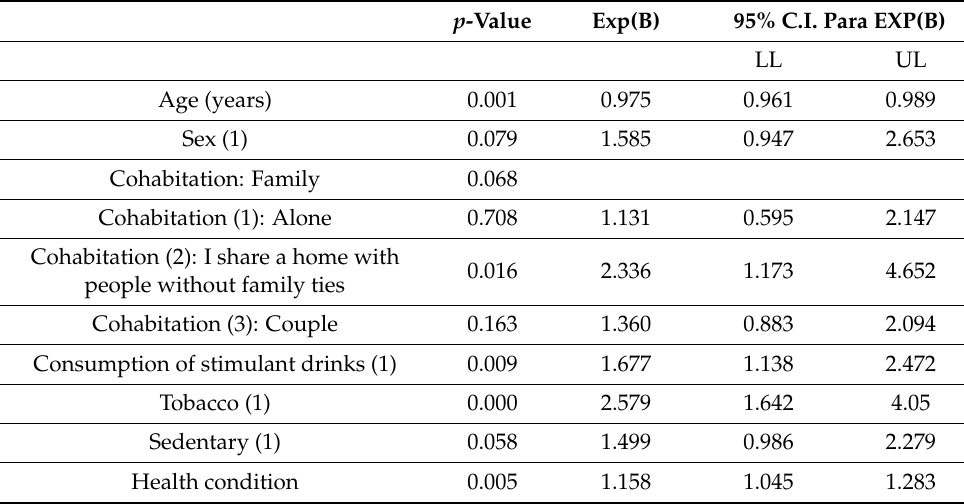
Table 8. Final logistic regression model: Variables associated with